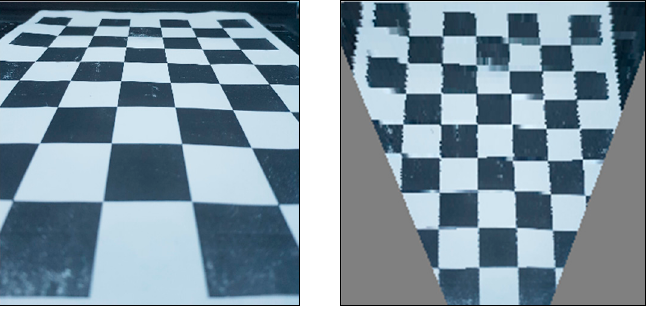
Figure 13. Perspective correction on checkerboard.